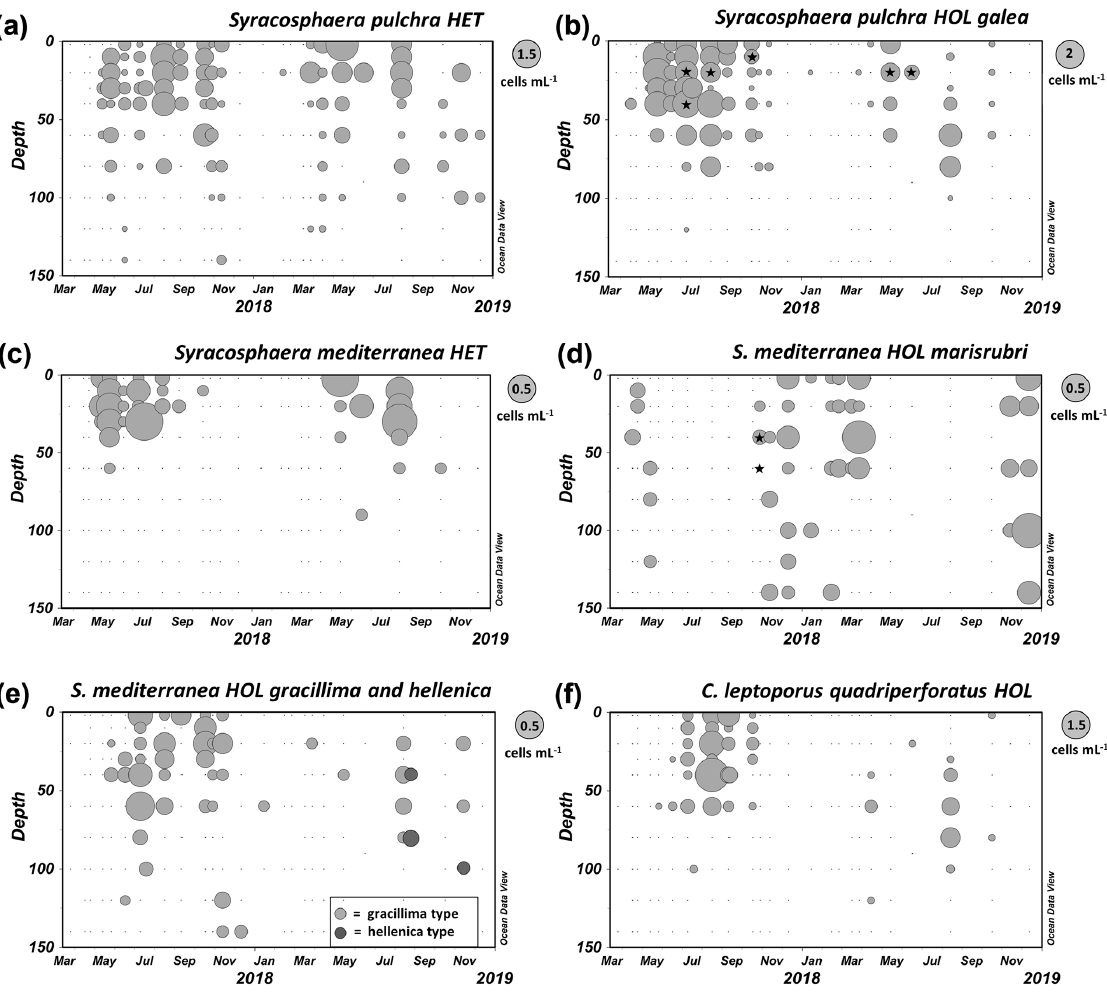
Figure 6. Distribution of coccolithophores in the GoA between March 2017 and December 2018. (a, b) Syracosphaera pulchra HET and Syracosphaera pulchra HOL galea type. (c–e) Syracosphaera mediterranea HET and three alternative types of HOL cells: marisrubri, gracil- lima and hellenica . (f) HOL phase of Calcidiscus leptoporus subsp. quadriperforatus . The asterisks denote samples in which combination coccospheres were found (each bubble in the plots represents one sample, and the diameter of each bubble depends on the cell density according to the respective legend on the upper right side). Raw cell count data are available in Table